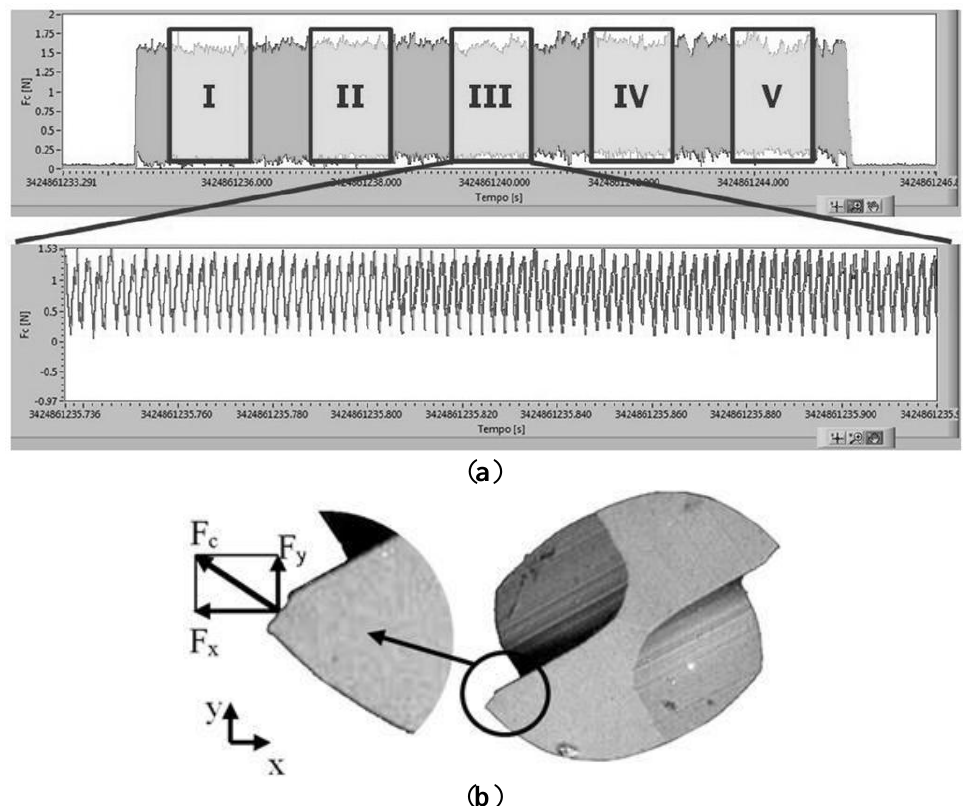
Figure 5. ( a ) Cutting force signal from Nationa Instrument LabVIEW based data acquisition system (DAQ) (bimodal microstructure and feed-per-tooth equal to 0.5 μm/tooth) and ( b ) process forces